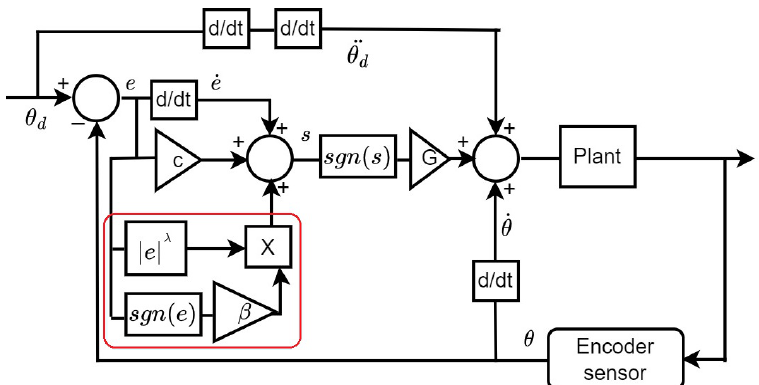
Figure 5. Block diagram of the proposed control structure.